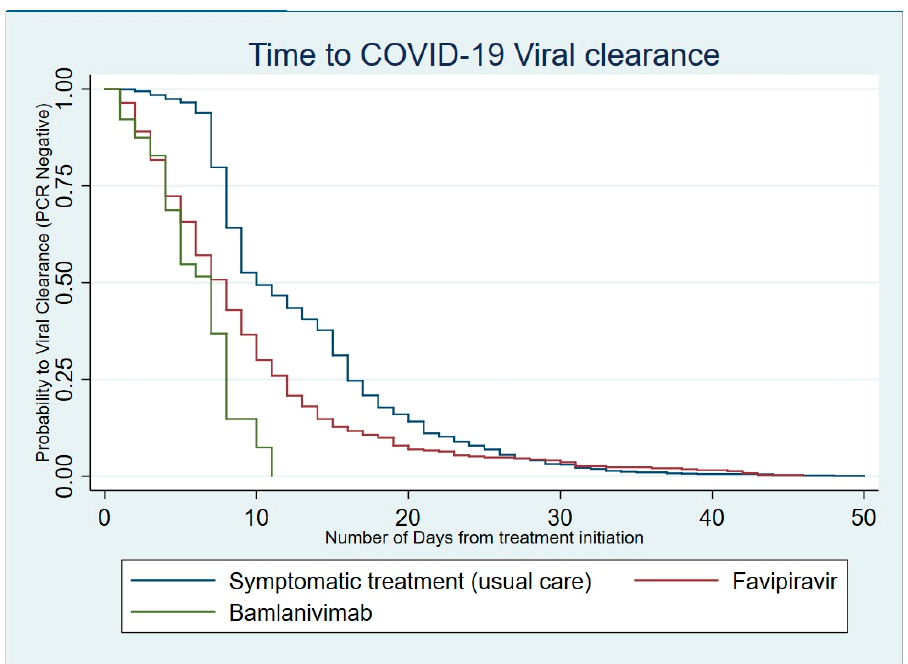
Figure 4. Kaplan–Meier curve for viral clearance according to the therapeutic intervention. Similarly, the majority of patients (75%) treated with favipiravir also cleared the virus within 11 days. However, a proportion close to 10% shed the virus for more than 20